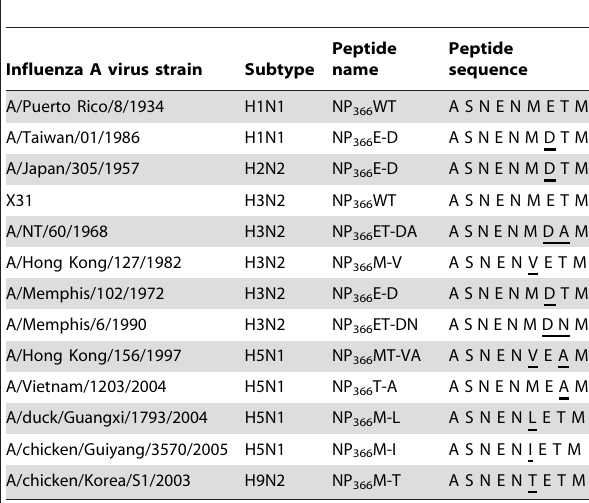
Table 1. Naturally occurring NP 366 /D b CTL epitope variants